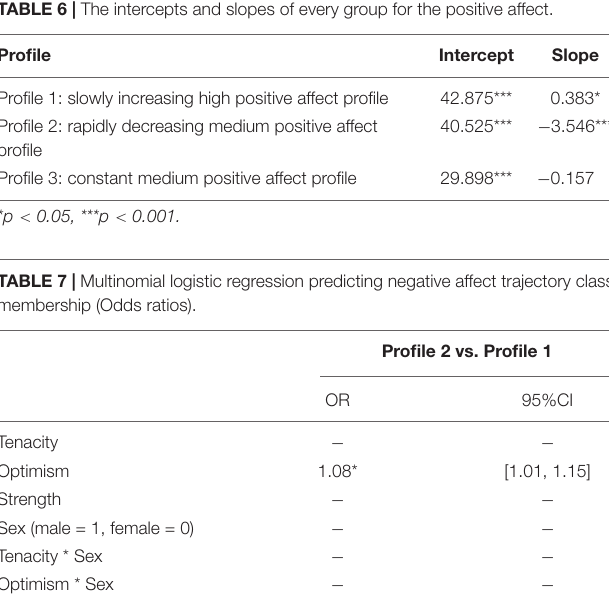
TABLE 4 | The intercepts and slopes of every group for the negative affect.